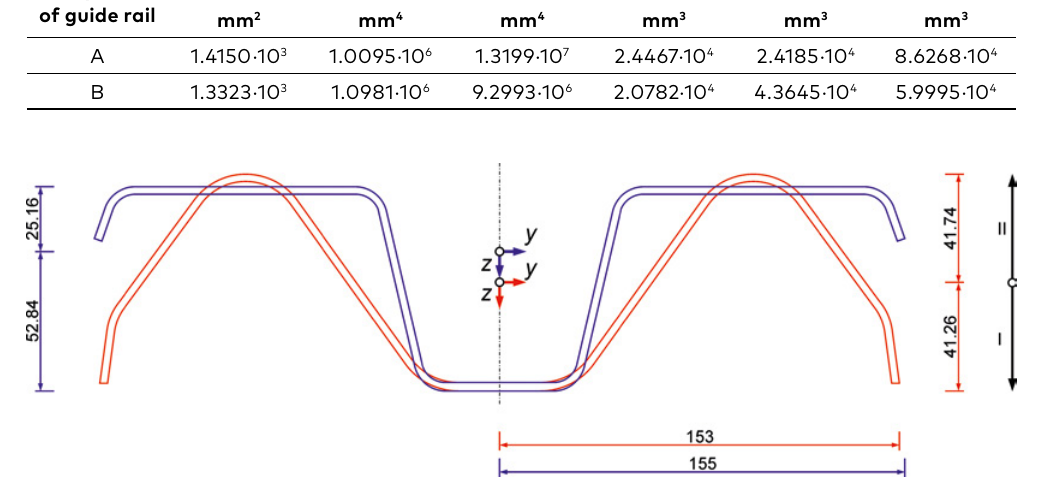
Figure 2. Comparison of cross-sections of type A and B guide